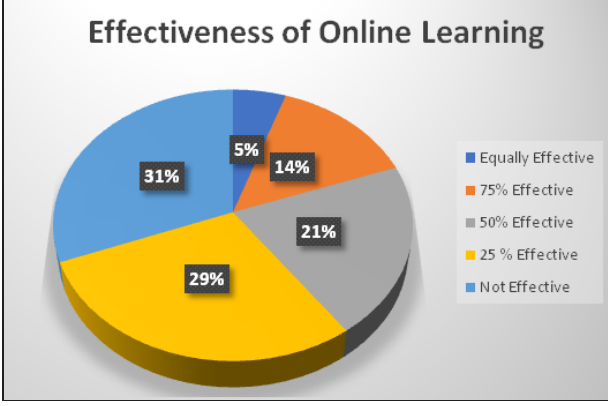
Figure-III: The response of students